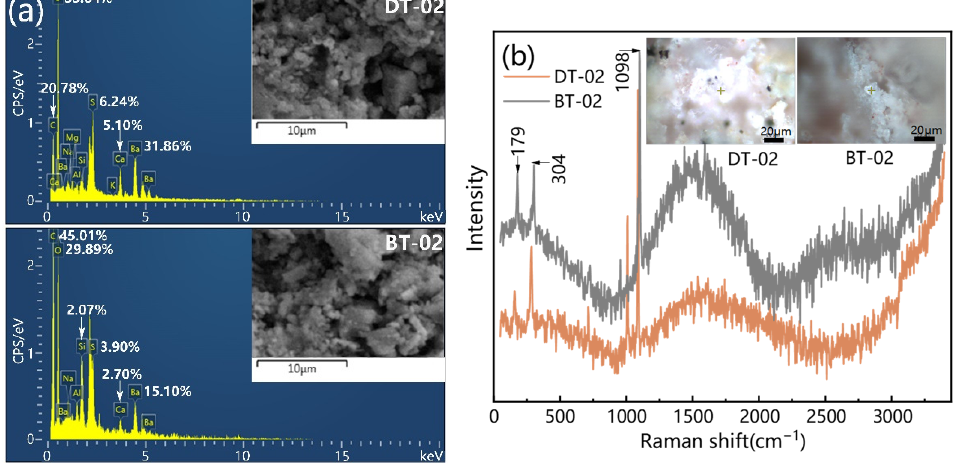
Figure 5. ( a ) Elemental analysis by SEM-EDS and ( b ) Raman spectra for the white samples (DT-02 and BT-02).